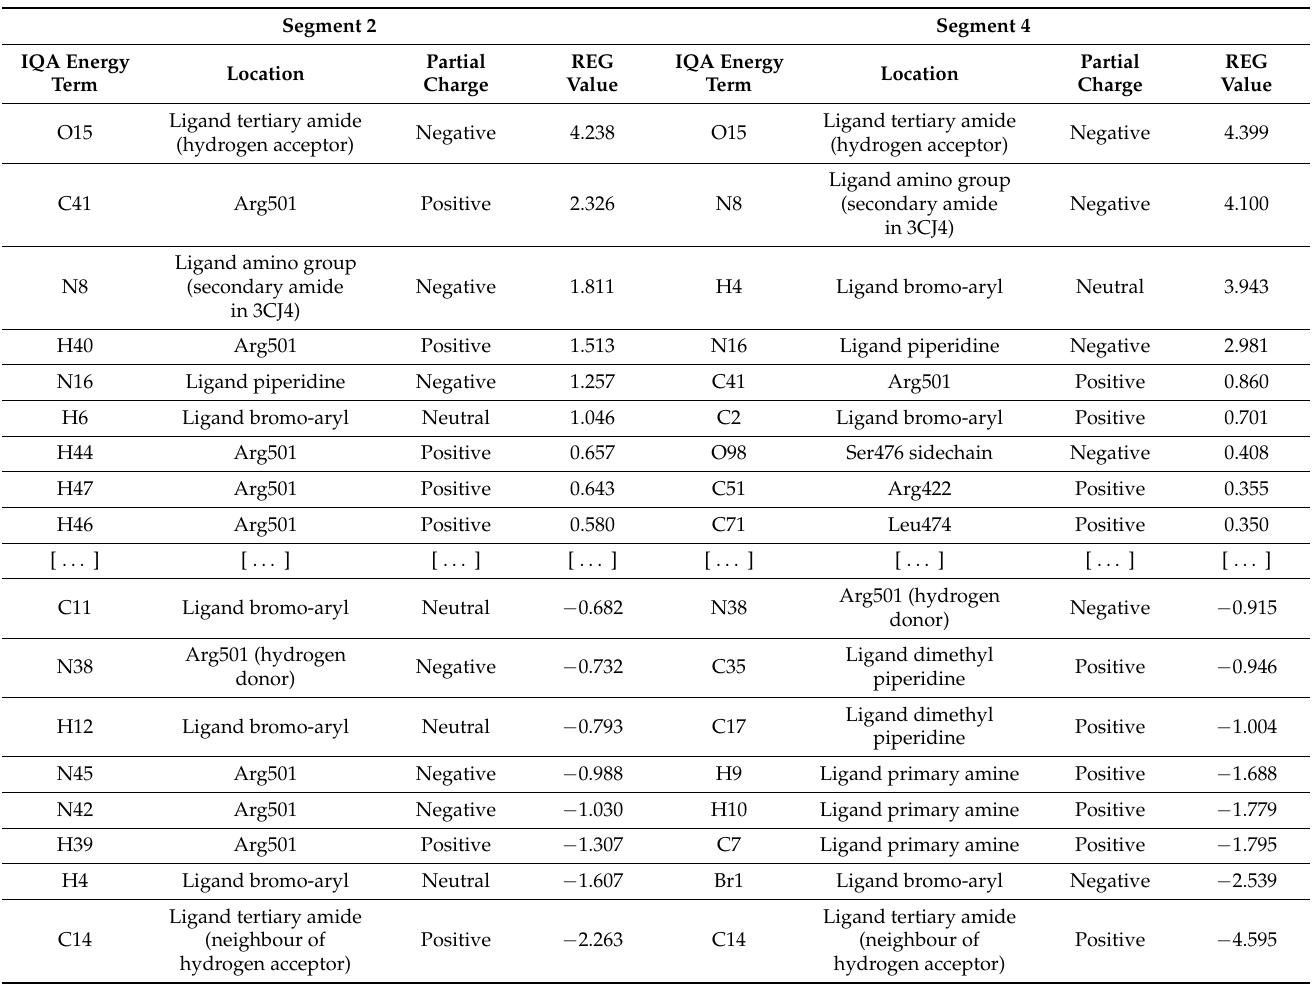
Table 6. Top and bottom REG values ( A-A (cid:48) rankings) for segments 2 and 4 in